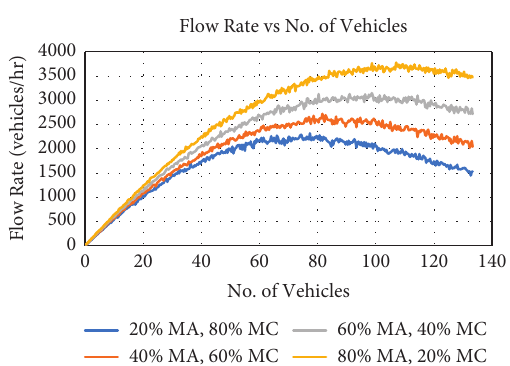
Figure 22: Flow rate vs. no. of vehicles fundamental diagrams for different compositions of MA and MC.